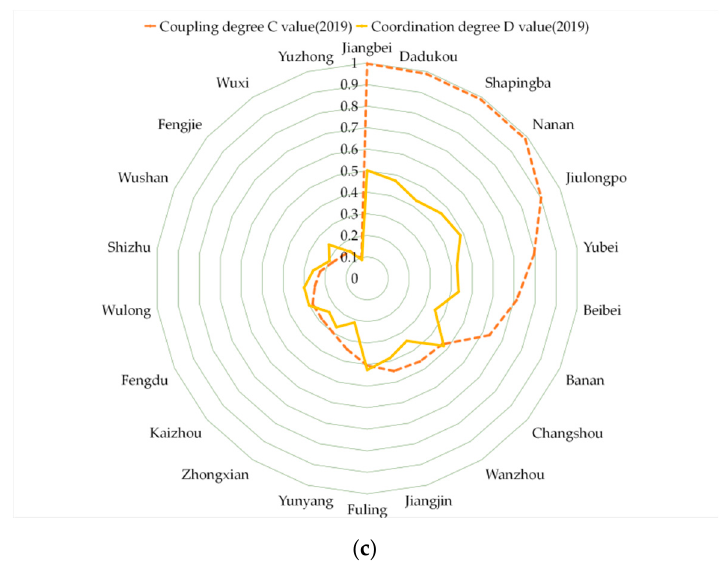
Figure 11. Comparison of UDI-ECC coupling degree and UDI–ECC coordination degree in 2010(a), 2014(b), and 2019(c). Sources: Calculation results of the CCD model.